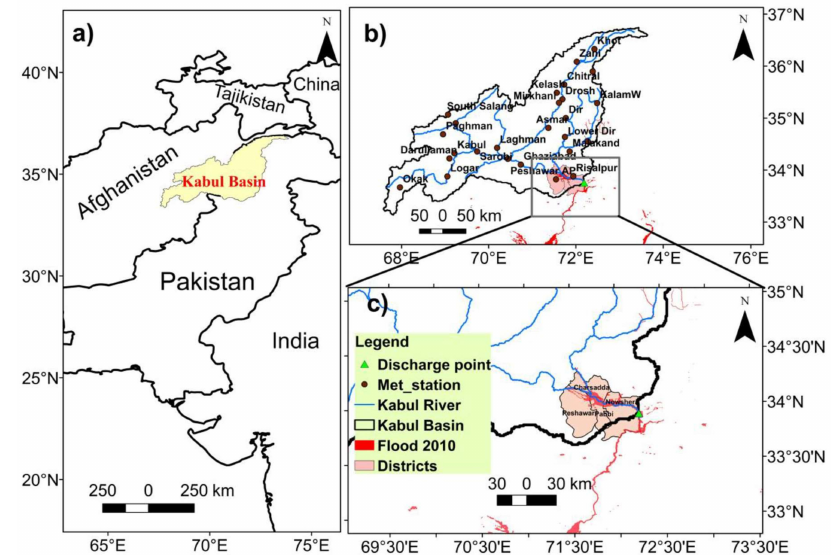
Figure 1. Near Here Study map of Kabul basin Afghanistan and Pakistan ( a ) geography of the basin ( b ) Kabul basin, including all the major tributaries of the main river as this river is the part of upper Indus basin ( c ) flood prone urban areas in the lower part of Kabul basin in Pakistan. The green triangle is the gauge station from where the discharge data is